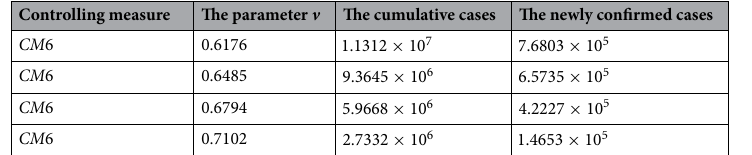
Controlling measure